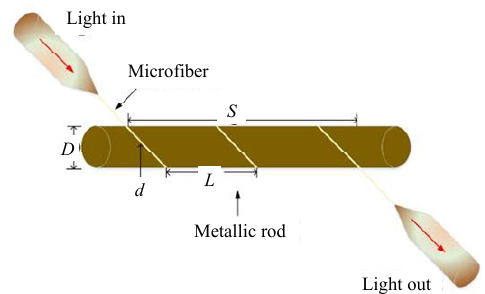
Fig. 1 Schematic diagram of the HMF